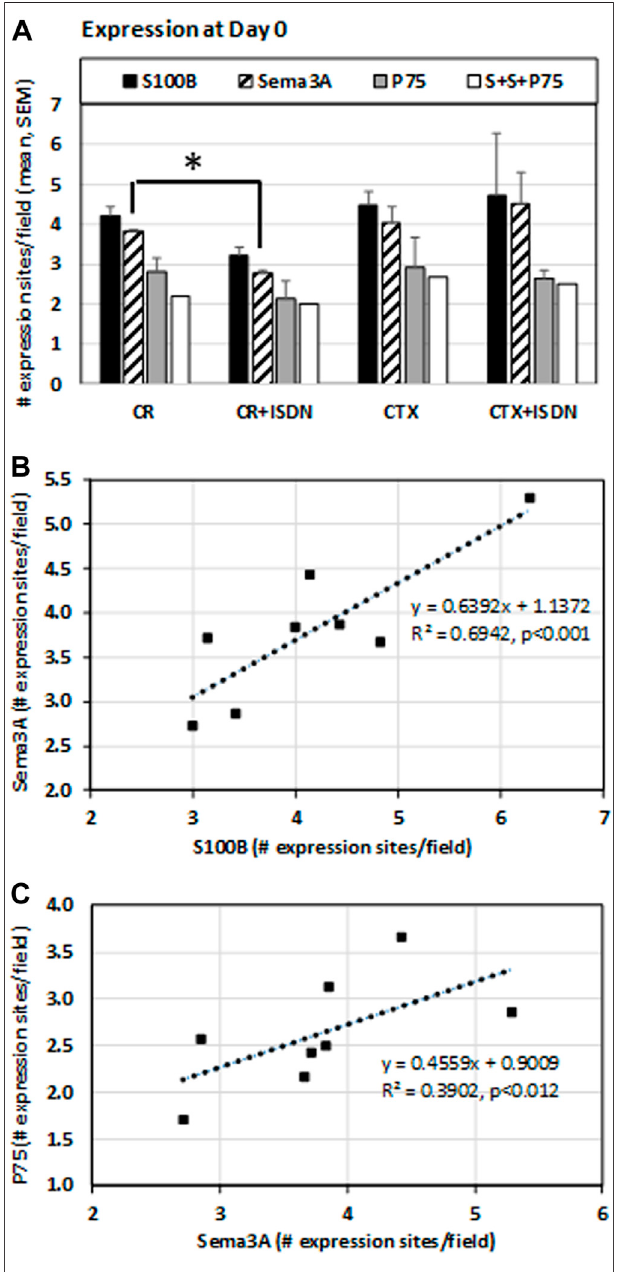
FIGURE 5 | Expression at day 0 after injury. Expression sites of S100B and Sema3A transcripts and P75 protein were identi fi ed using fl uorescent in situ hybridization and immunostaining, respectively, in muscle-crush (CR)- and cardiotoxin-injured muscles from mice either treated with ISDN for 2 days before injury (+ISDN) or controls without treatment (no ISDN). In this staining experiment, n = 2 per group. The number of fl uorescent expression number of sites with a colocalized expression of S100, Sema3A, and P75 (indicated as S + S + P75) (A) . At day 0, the number of Sema3A expression sites was signi fi cantly lower after CR injury in ISDN-treated mice than in the ( Continued )